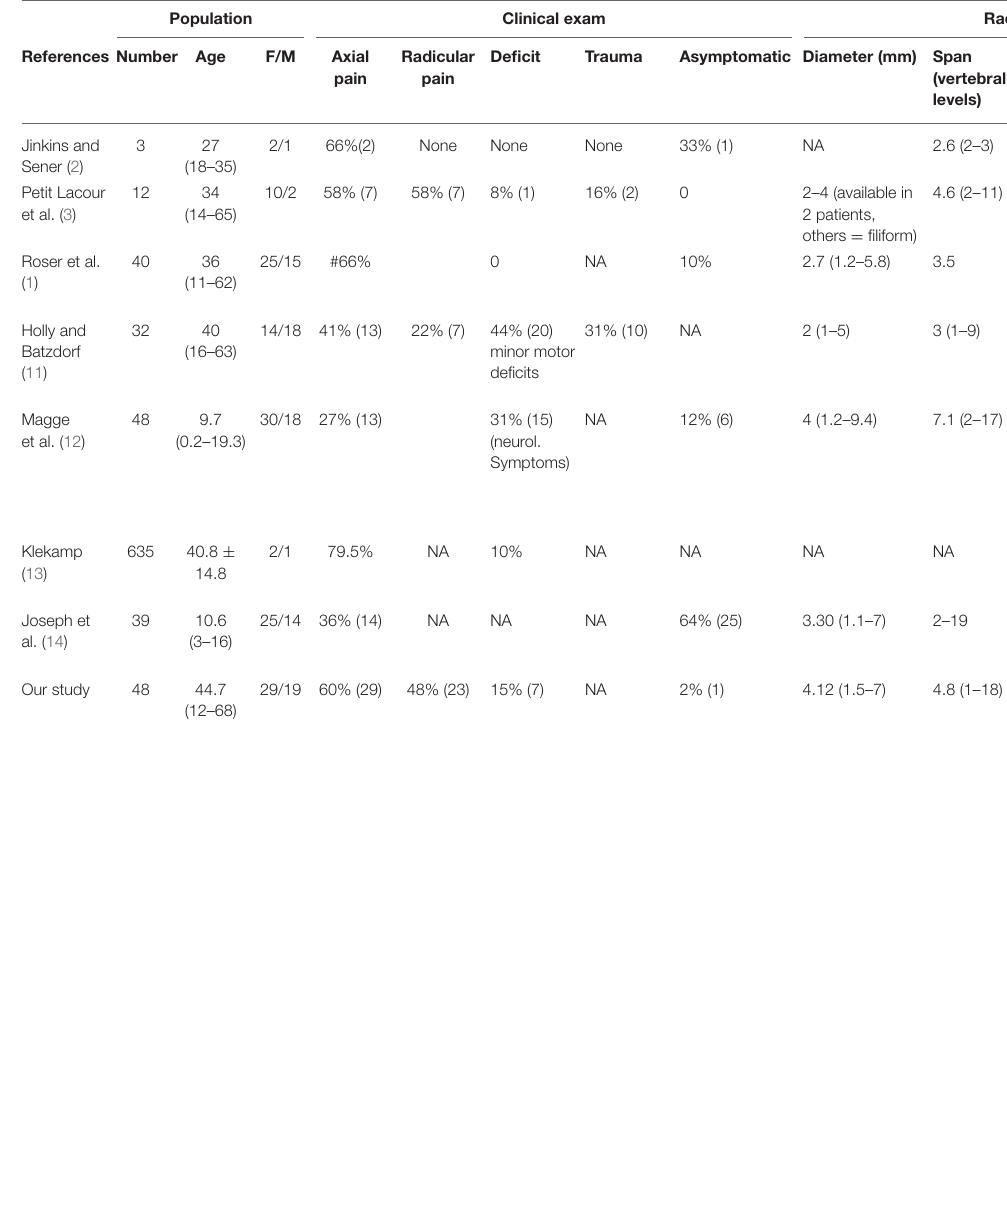
TABLE 1 | Comparison of our results with the literature.